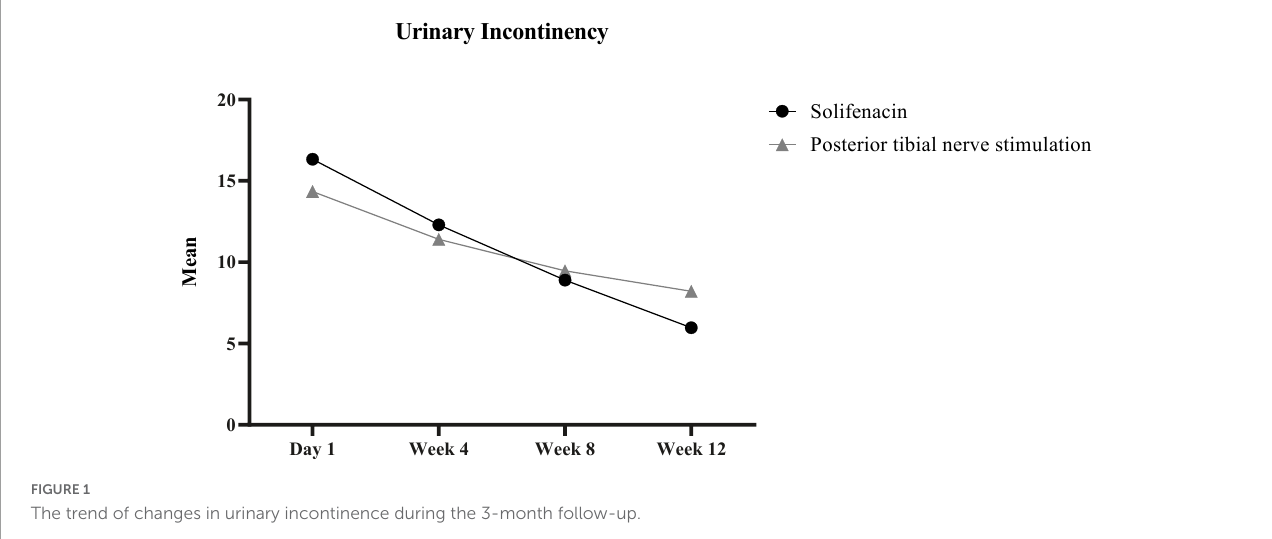
FIGURE1 The trend of changes in urinary incontinence during the 3-month follow-up.